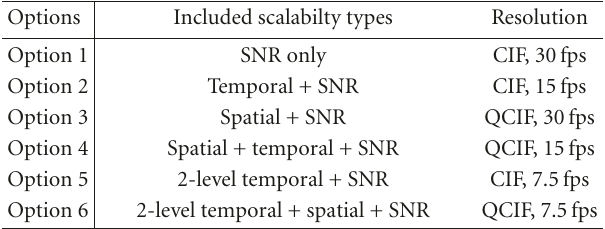
Table 1: Scaling options, included scalability types, and resulting resolutions